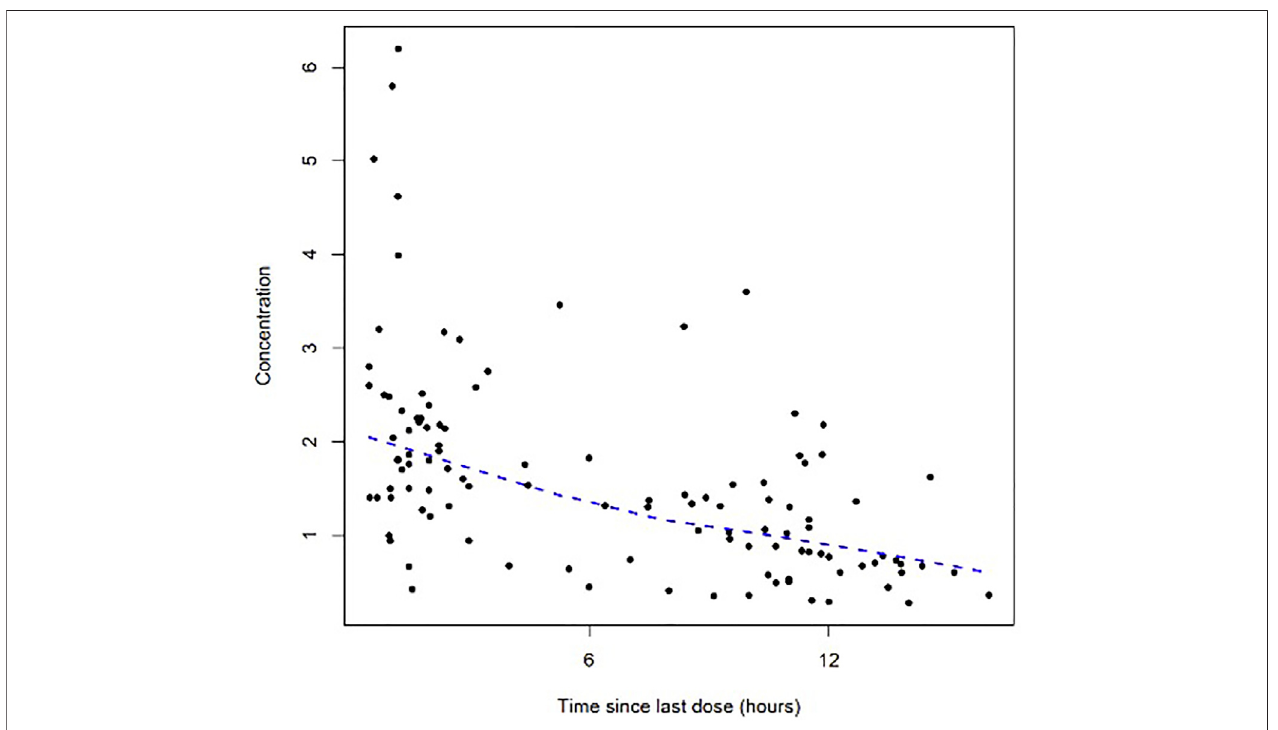
FIGURE 1 | Dose-normalized serum concentration – time pro fi les of colistin.